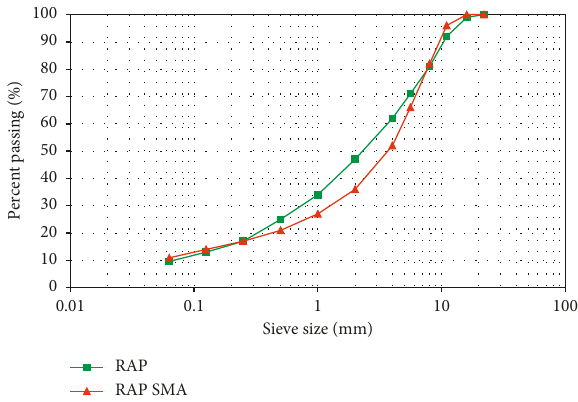
Figure 2: Sieve size distribution of used